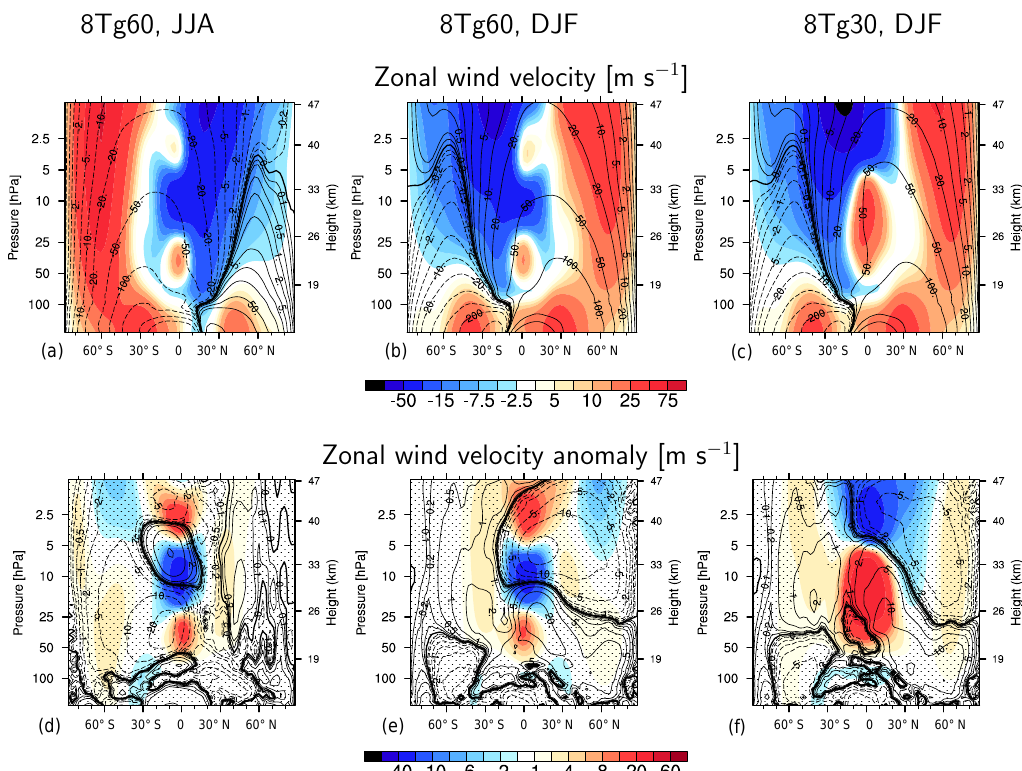
Figure 3. Zonal mean zonal wind velocity (a–c) and the anomaly of the zonal wind velocity (d, e, f) for injection of 8Tg ( S ) yr − 1 at 60hPa ( a, b, d and e ) relative to control run at Northern Hemisphere summer (JJA, a, d ) and winter (DJF, b, e ) and DJF for an injection at 30hPa (c, f) . Contour lines show the stream function [kgs − 1 ] (a–c) and the difference of the streamfunction to the control simulation [kgs − 1 ] (d–f) for the two seasons. Results are compared to a control simulation which includes different phases of the QBO. Stippling indicates areas which are not significant at the 95%